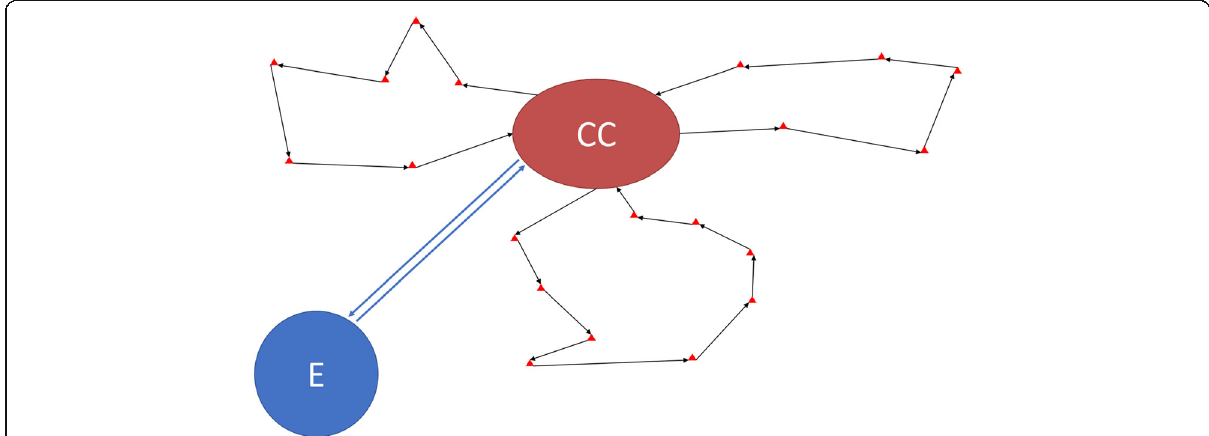
Fig. 3 Current food transport system from E warehouse to middle school canteens trough the Central kitchen (CC) with single-stage and multiple